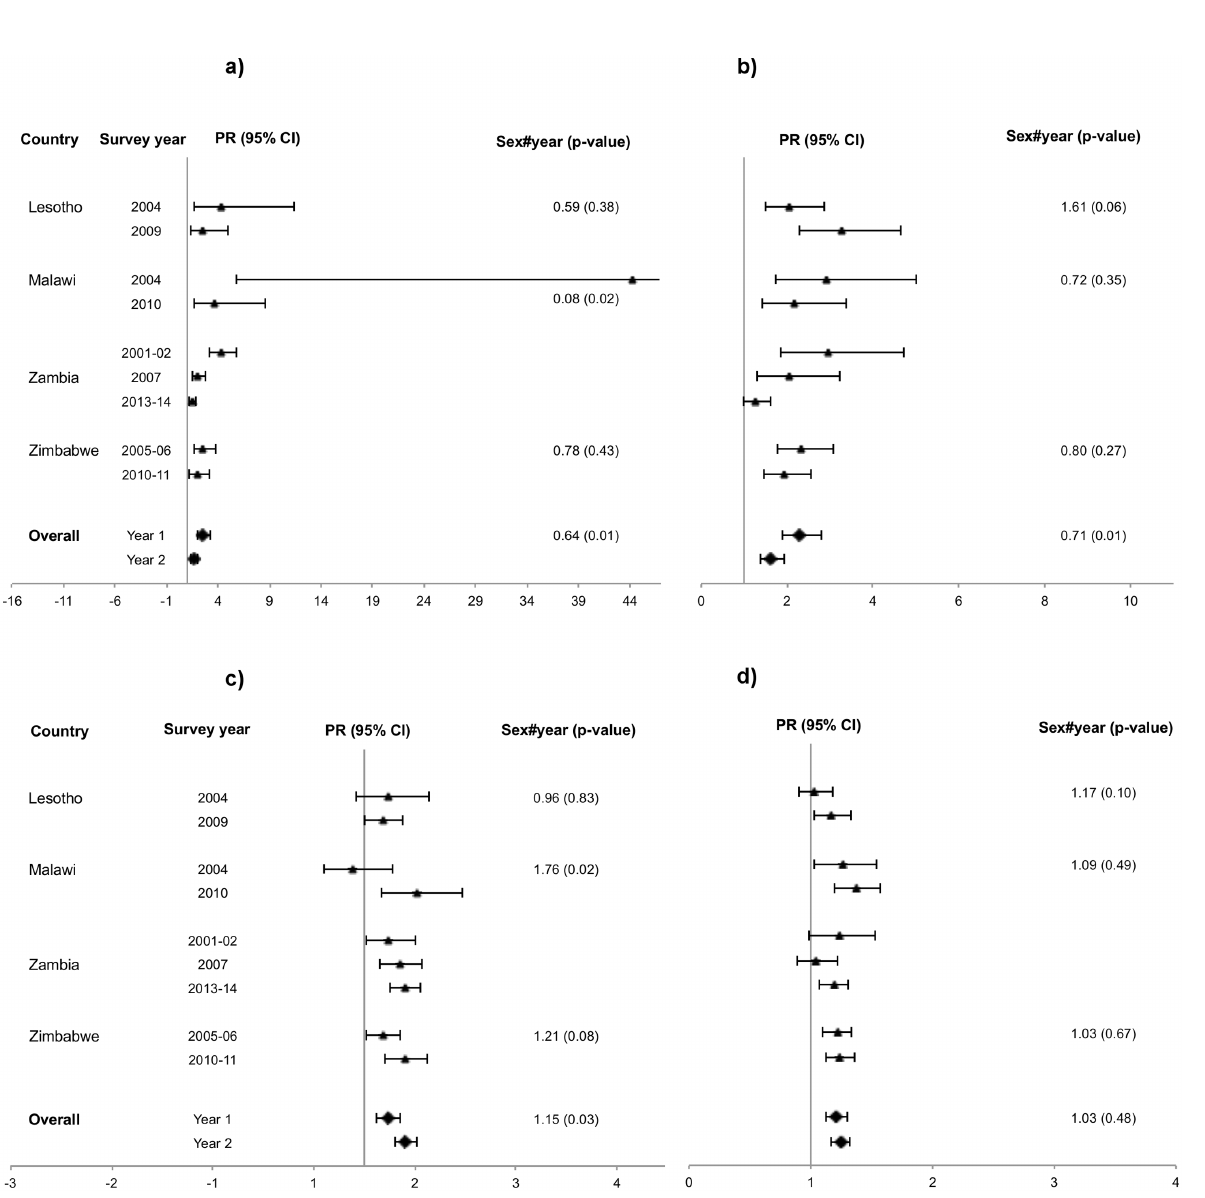
Fig 3. Southern Africa, age-adjusted female: male HIV prevalence ratios. (a) Urban, 15 – 24 years. (b) Rural, 15 – 24 years. (c) Urban, 25 – 49 years (d) Rural, 25 – 49